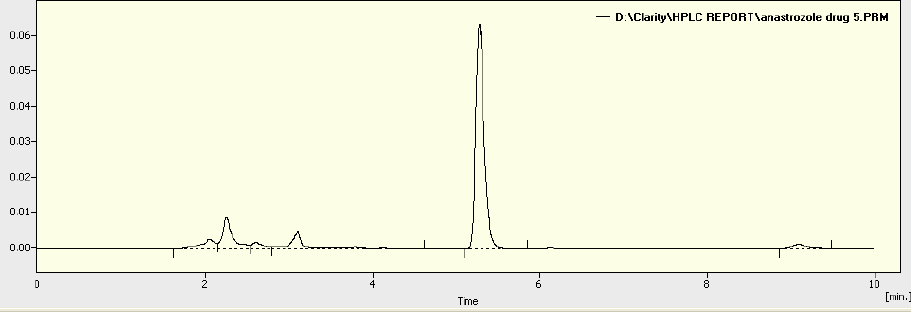
Figure 1. Chromatogram of anastrozole